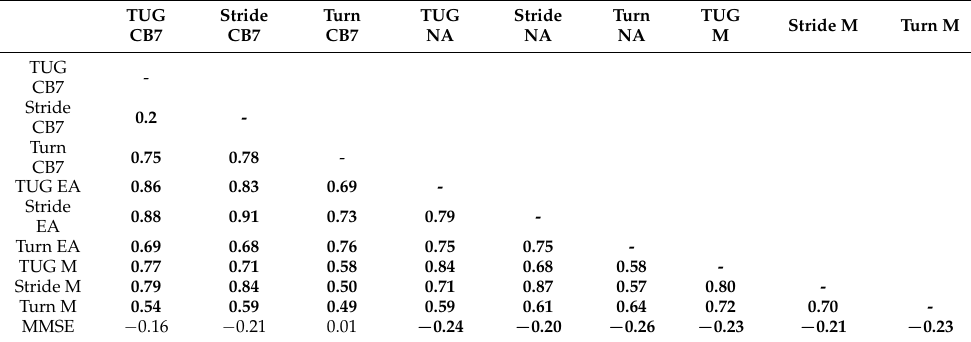
Table 4. Correlation between cognitive test score and dual task test